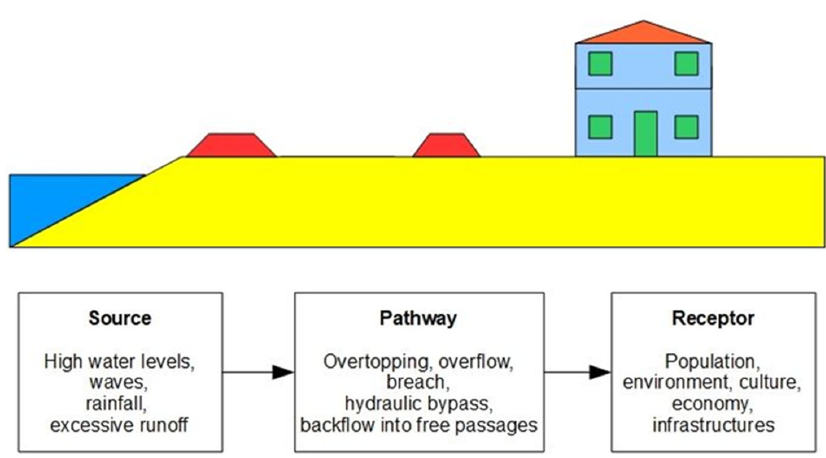
Figure 6. Representation of the SPR model.